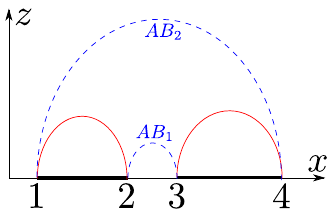
Figure 16 . For the union of the two intervals A (from 1 to 2) and B (from 3 to 4), there are two possible ways how to calculate the entanglement entropy S ( A [ B ). One is by adding the entanglement entropies of the two intervals A and B (given by the solid red curves), the other is by adding the two curves AB 1 and AB 2 , depicted as dashed blue